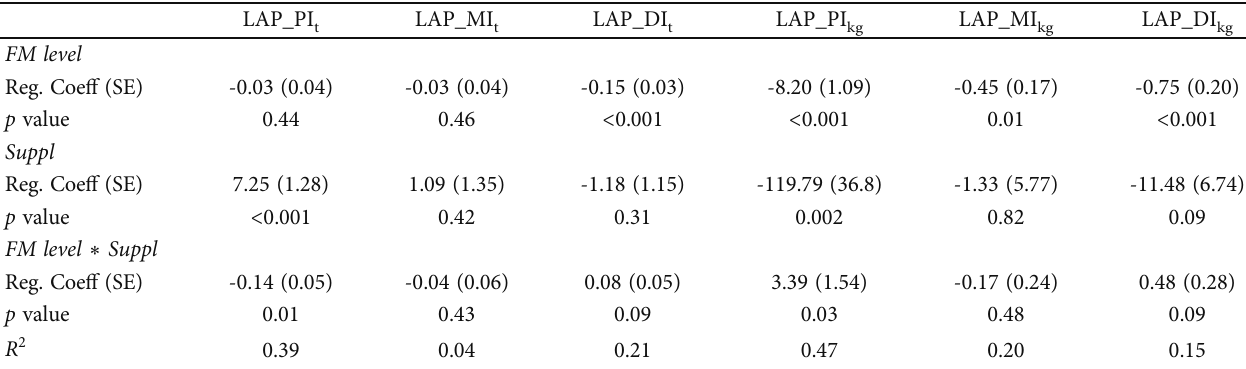
Table 6: Results of regression analyses regarding the activity of leucine aminopeptidase (LAP) in tissues from the pyloric (PI), mid (MI), and distal intestine (DI) expressed per mg tissue (t) and per kg of fi sh (kg) on fi shmeal level, based on individual observation †‡ .